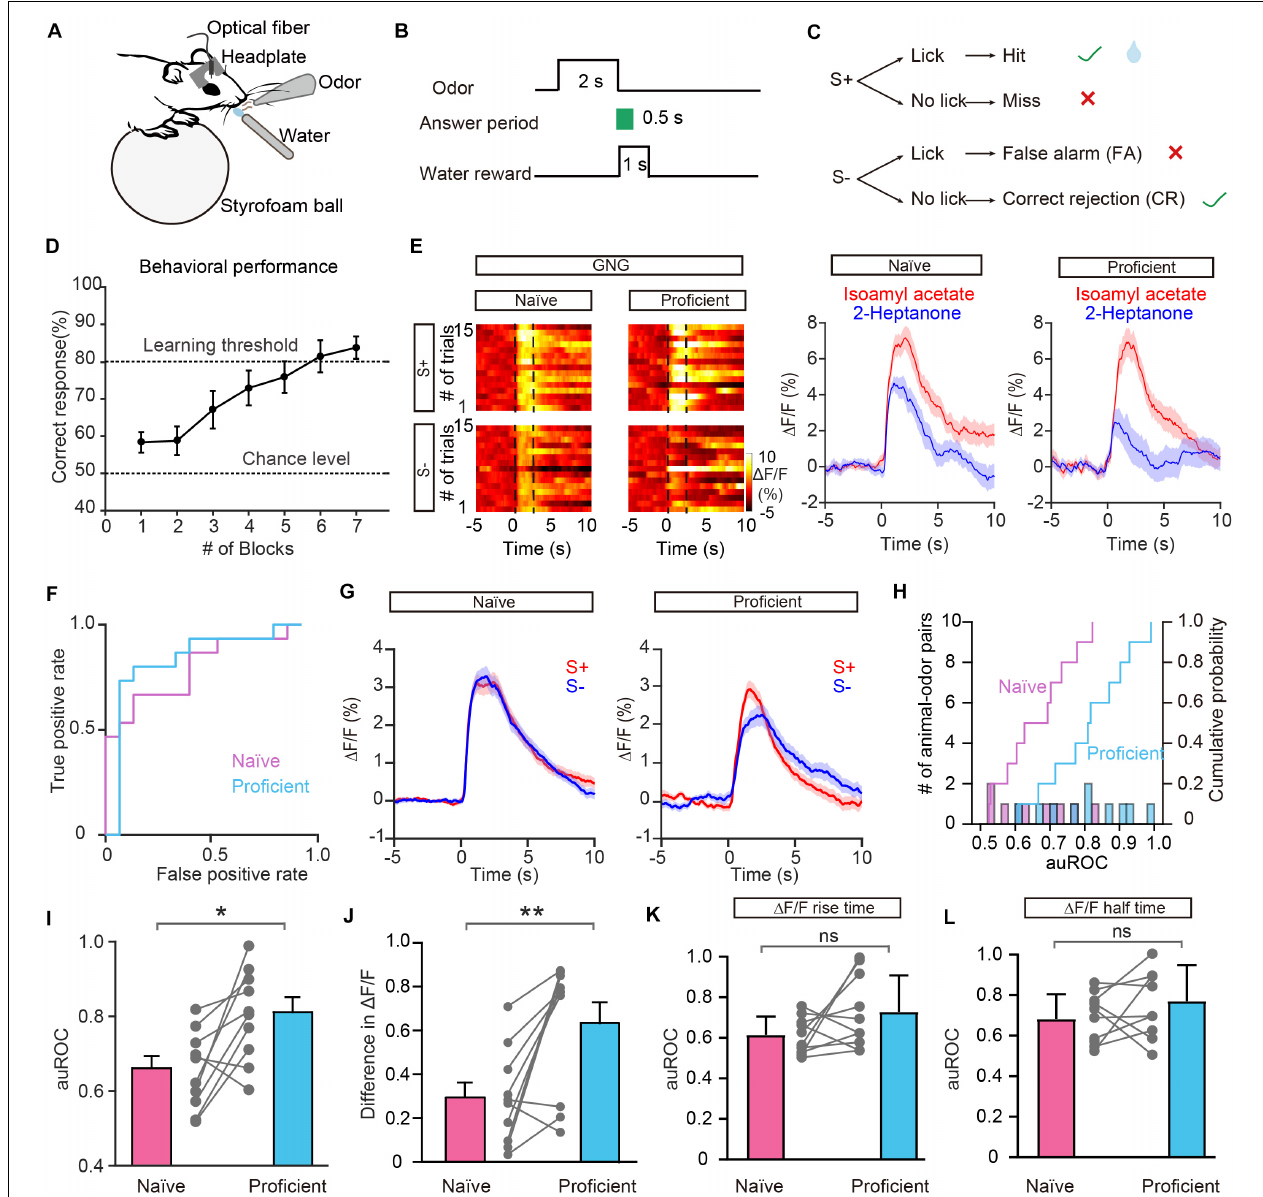
FIGURE 4 | Odor responses in GCs show improved separation in the go/no go (GNG) task. (A) Diagram of the experimental set-up. (B) Timeline for a single trial. Each trial consisted of a 2 s odorant delivery period, followed by a 0.5 s answer period during which the mouse could choose whether or not to lick a lickport. A water reward was delivered if the stimulus was rewarded (S+) and the mouse licked during the answer period. (C) Schematic of behavioral paradigm. If an S+ was presented and the mouse responded with licking, a water reward was delivered. If an S– was delivered, no water reward was delivered regardless of the mouse’s actions. (D) Odor discrimination performance during the last session in the go/no go task. The mean percentage correct responses are plotted for each block of 20 trials. The chance level and learning threshold are indicated by dashed lines. (E,F) Heat maps (E) , peri-event plots (E) , and ROC graph (F) of Ca 2 + signals from an individual mouse induced by S+ and S– in the naïve stage and in the proficient stage during the go/no go task. (G) Averaged traces of odor responses across all animal-odor pairs ( n = 10 animal-odor pairs from nine mice). (H) Histograms and cumulative probability of auROCs in the naïve stage and the proficient stage. (I,J) auROCs (I) and difference in (cid:49) F/F (J) are larger in the proficient stage than in the naïve stage. [ I: paired t -test, t ( 9 ) = 3.15, P = 0.0118; J: Wilcoxon’s sign rank test, W = –49.0, P = 0.00980.] (K,L) Comparison of the auROC values of (cid:49) F/F rise time (K) and half time (L) between the naïve stage and proficient stage. [ (K) paired t -test, t ( 9 ) = 1.68, P = 0.127; (L) paired t -test, t ( 9 ) = 1.32, P = 0.221]. * P < 0.05, ** P <